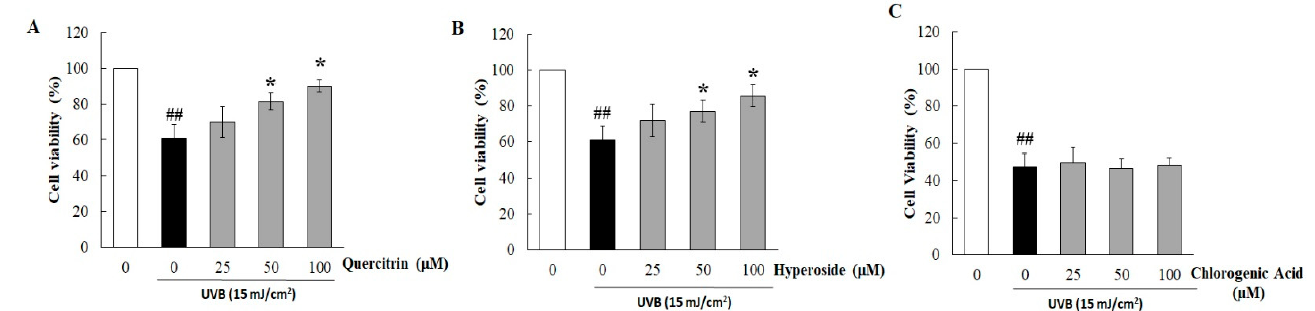
Figure 2. Cytoprotective effects of major compounds in HC-EA on UVB-induced cytotoxicity in HaCaT cells. The cells were pretreated with various concentrations of quercitrin ( A ), hyperoside ( B ), and chlorogenic acid ( C ) for 6 h before UVB-irradiation after 24 h the cells viability was measured by SRB assay. * p < 0.05 as compared to the UVB-irradiated alone group. ## p < 0.01 as compared to the non-UV group. Data are representative of three independent experiments as mean ± SD.